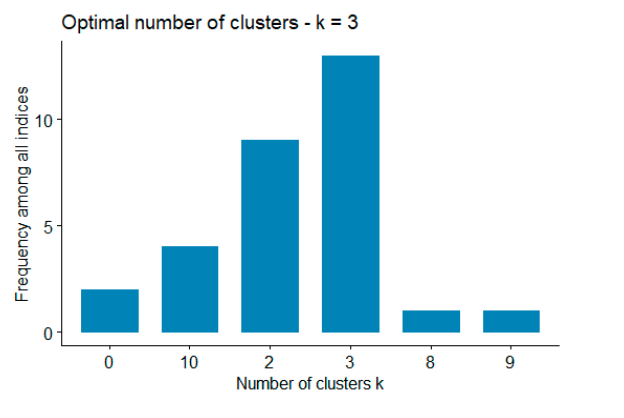
operating hours per day, and reactive power).